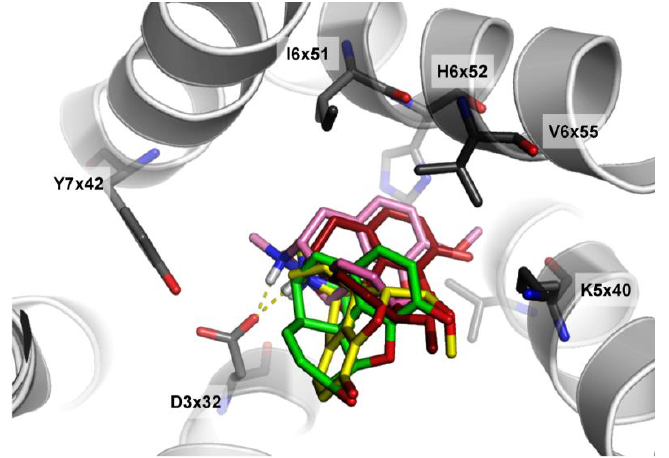
Figure 12. Docking results of CHEMBL358043 (yellow), CHEMBL409938 (green), CHEMBL369475 (pink), and CHEMBL3923831 (firebrick) in the binding site of the delta-opioid receptor (PDB ID: 4RWD). The yellow dotted lines represent the hydrogen bonds.